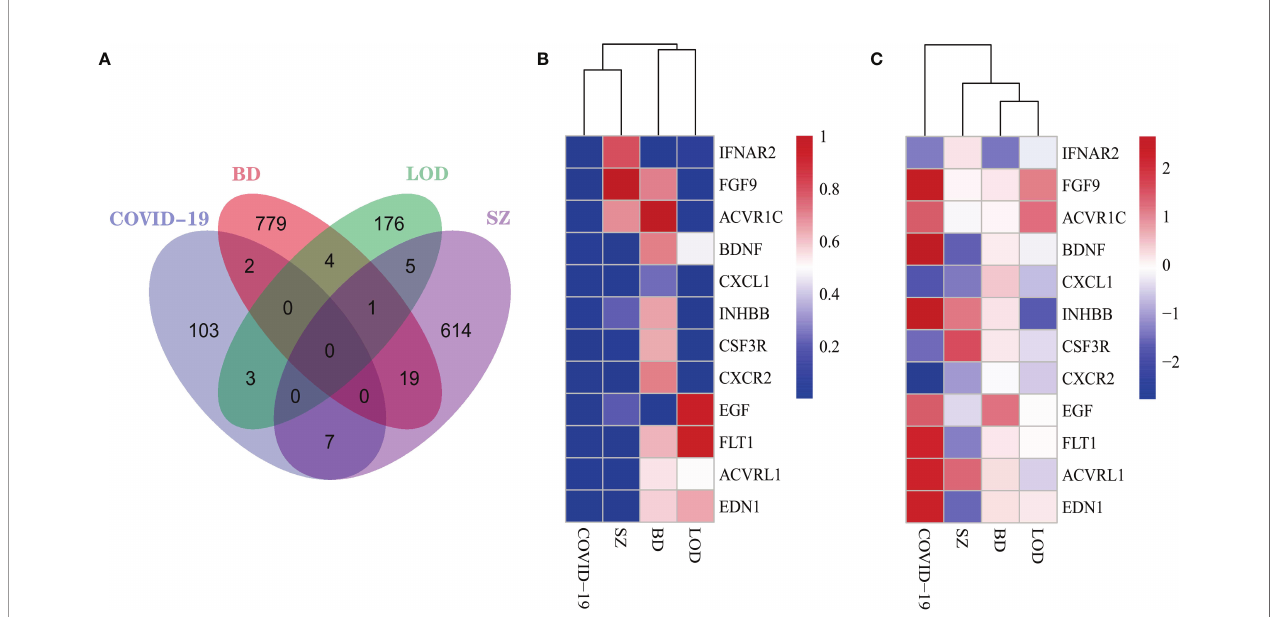
FIGURE 2 | (A) The Venn diagram illustrates the common DEGs in COVID-19 immune system and BD, SZ, and LOD. Heatmaps demonstrate the associations of DEGs based on (B) adjusted P -value and (C) log fold-change for all immune data